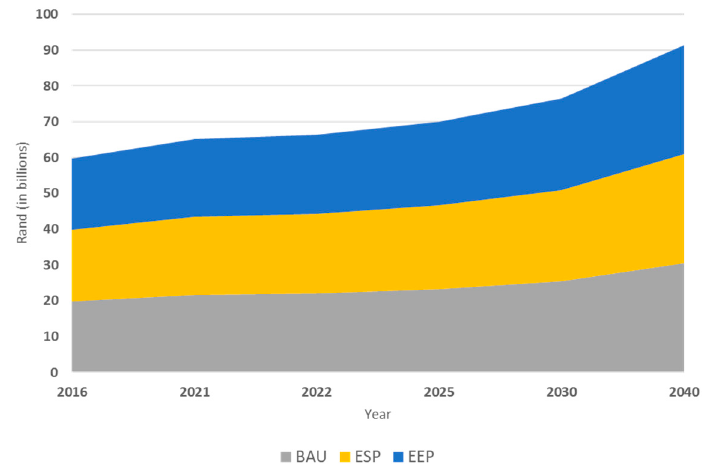
Figure 4. GVA in the BAU, ESP and EEP scenarios. Source: Authors.